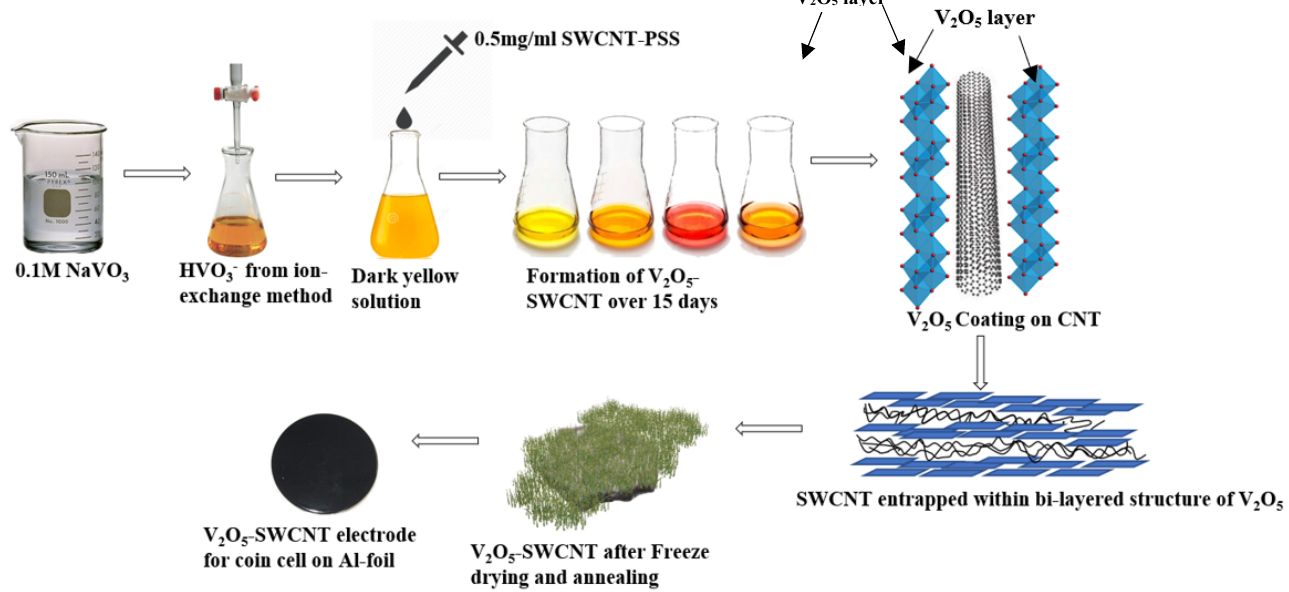
Figure 2. Schematic illustration of the synthesis and structure for the V 2 O 5 -SWCNTs composite. A 0.1 M solution of sodium metavanadate (NaVO 3 ) is passed through a proton-exchange filter column, and a yellow-colored HVO 3 − solution is obtained. This solution is then mixed with a SWCNT: PSS solution. This mixture slowly forms a V 2 O 5 xerogel, with the solution gradually shifting in color from yellow to dark red, marking the complete evolution of a 3D homogeneous network of V 2 O 5 -SWCNT hydrogel.